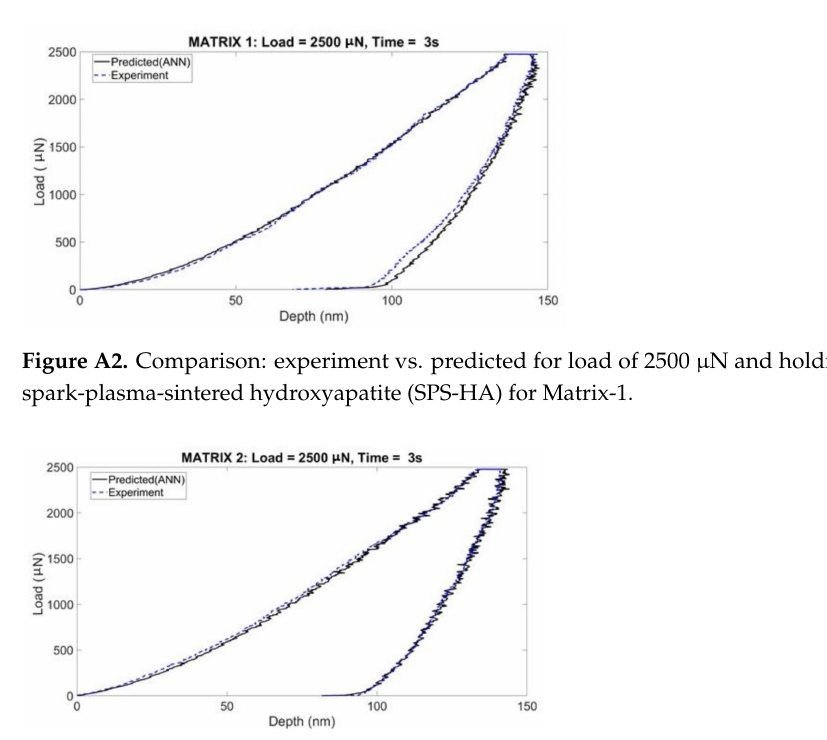
Figure A3. Comparison: experiment vs. predicted for load of 2500 µ N and holding time of 3 s for SPS-HA for